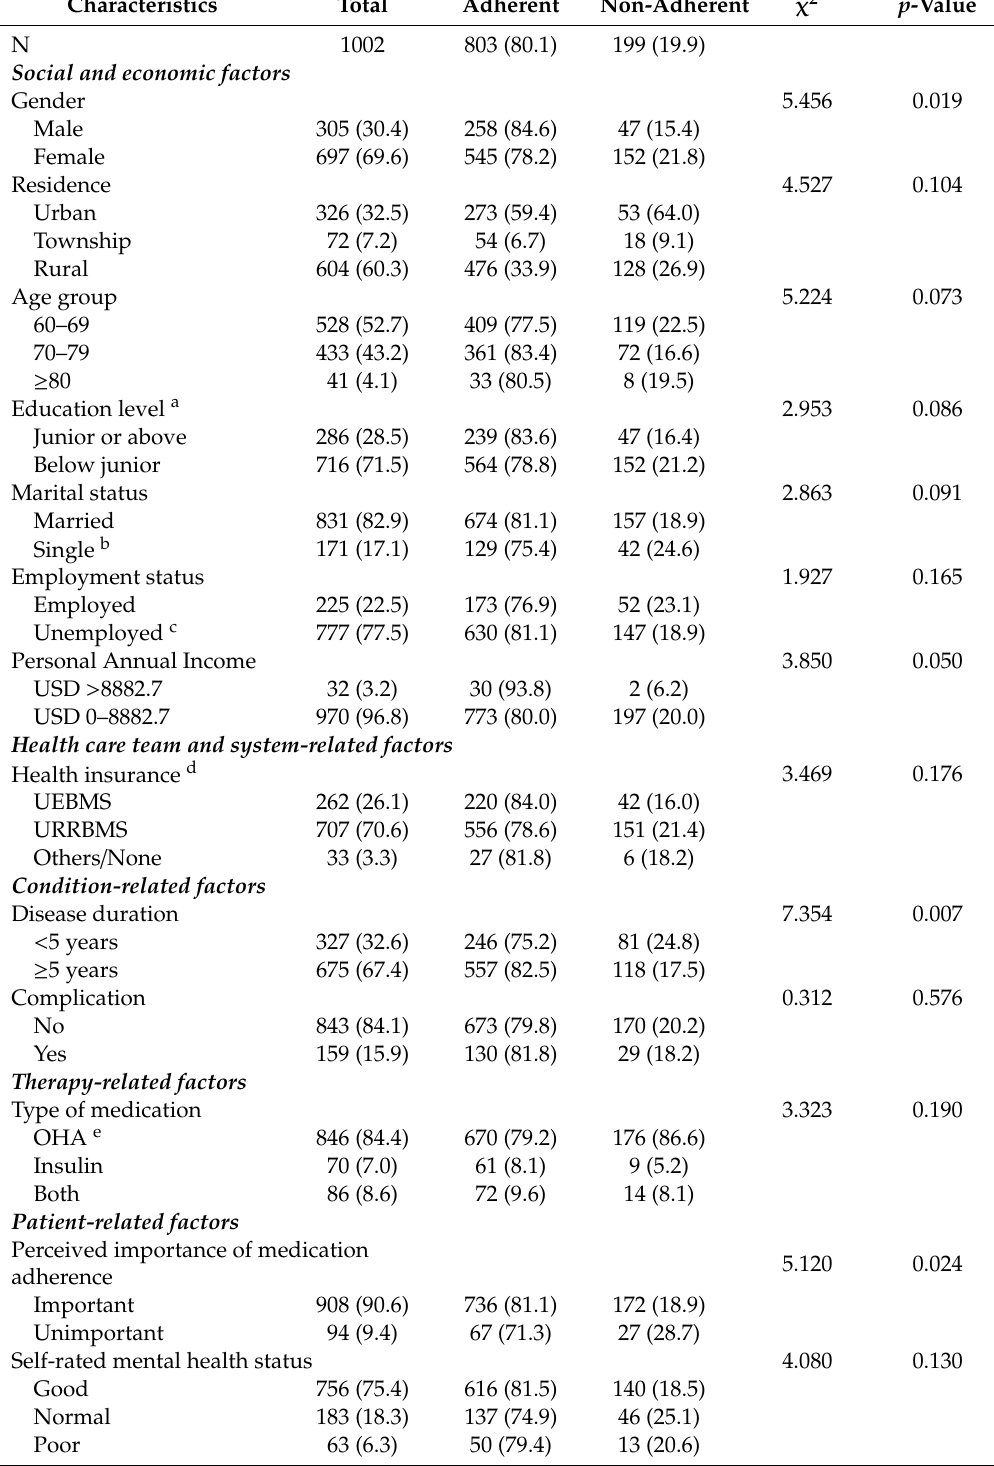
Table 1. Summary of respondents’ characteristics by level of medication